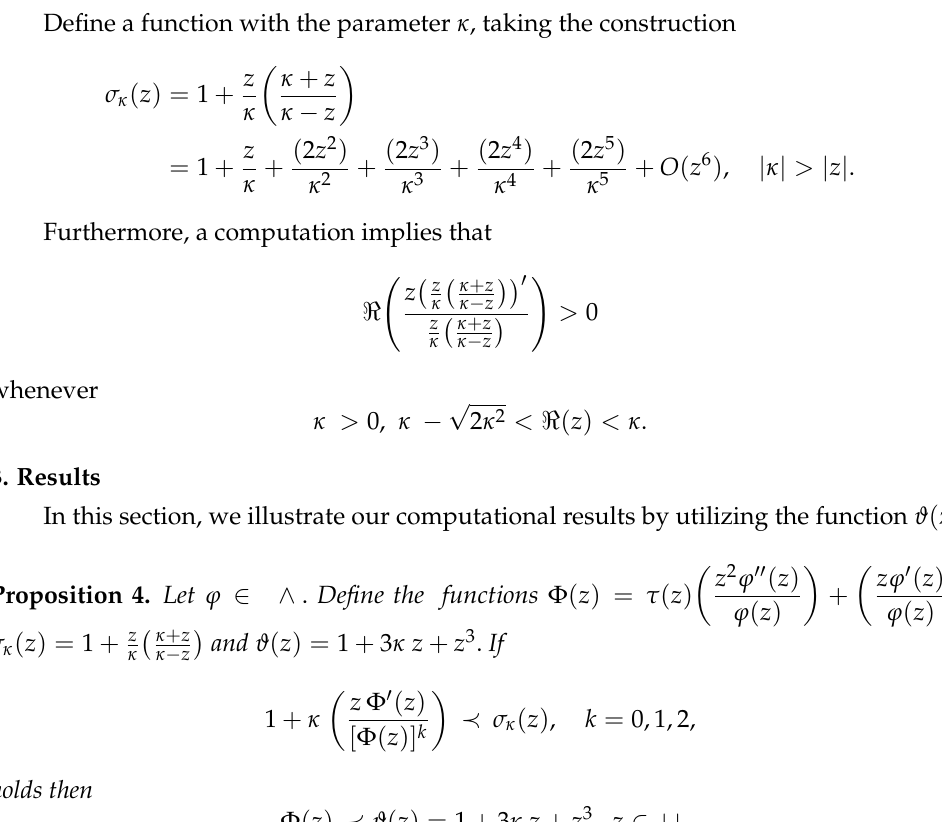
Figure 1. The plot of ϑ ( z ) and the relation with κ ; the fractal constant κ = −